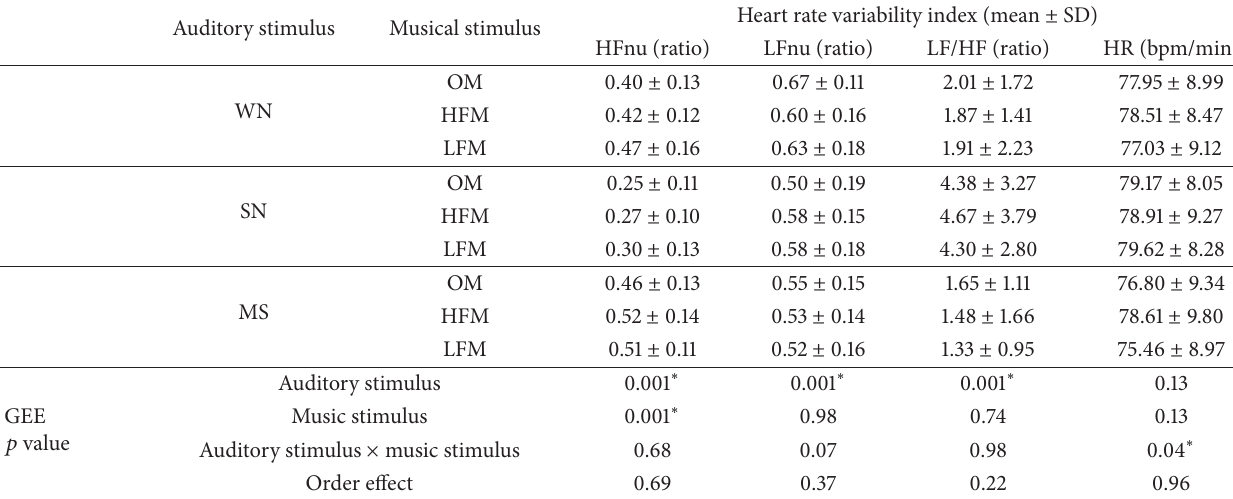
Table 1: Heart rate variability analysis.